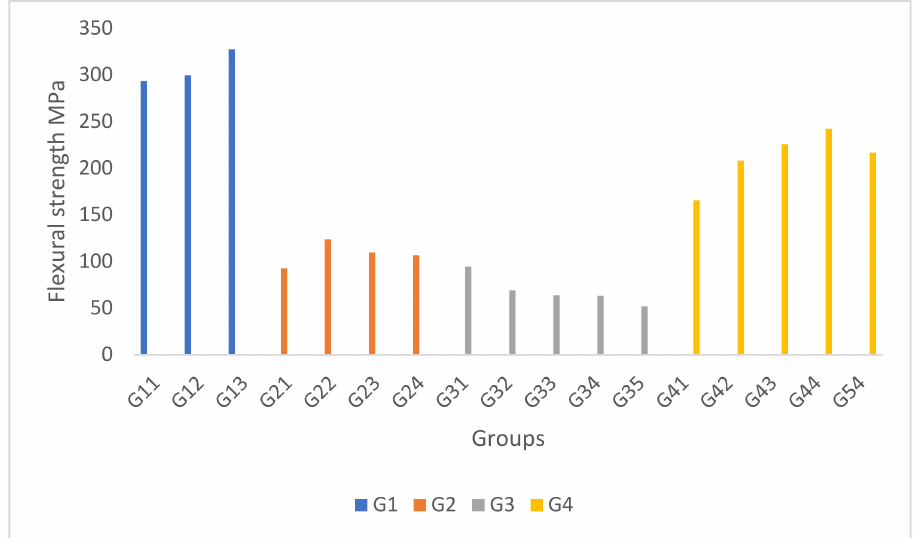
Figure 3. Flexural strength of the hybrid GFRP